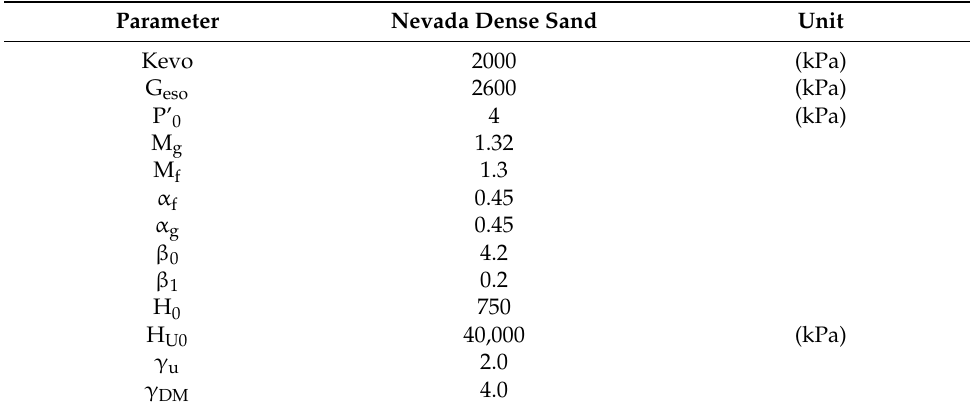
Table 1. Model parameters of the loose seabed soil for PZIII in analysis.